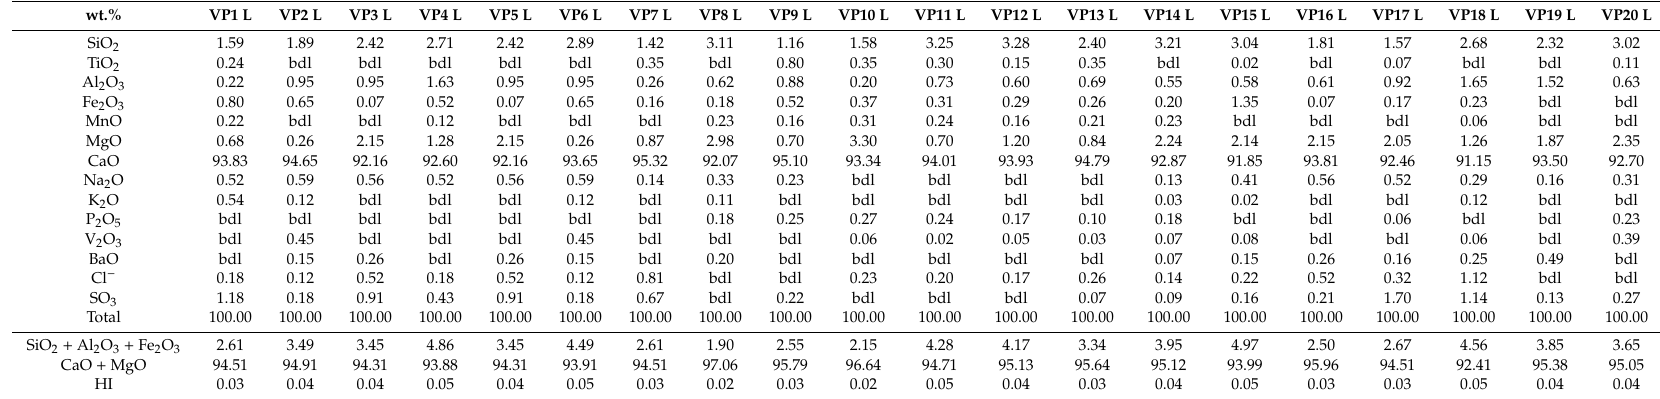
Table 4. Major element concentrations of lime lumps (L) in Villa del Pezzolo mortars (in wt.%; recalculated to 100%; bdl: below detection limits). SiO 2 + Al 2 O 3 + Fe 2 O 3 , CaO + MgO, HI (Hydraulic Index) are also shown.